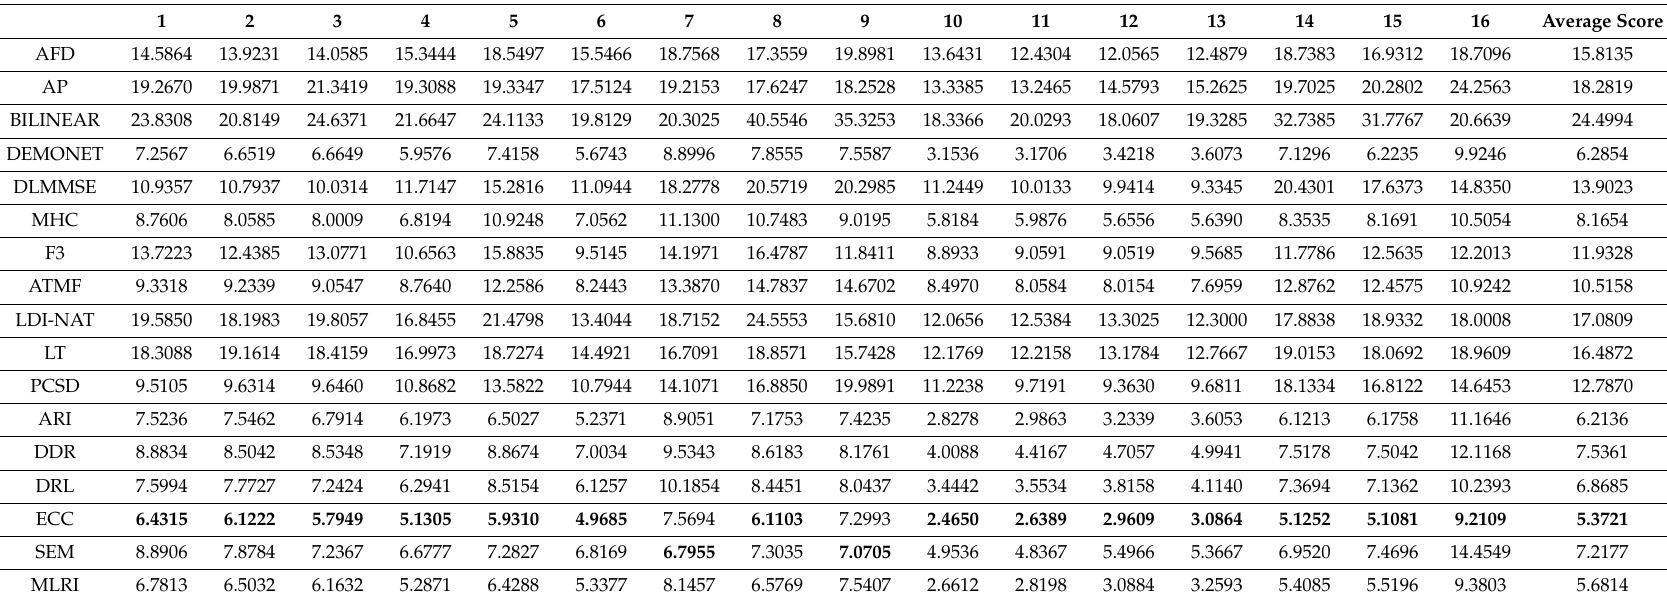
Table 3. Summary of NIQE scores (lower means better). Sixteen left images: Blue